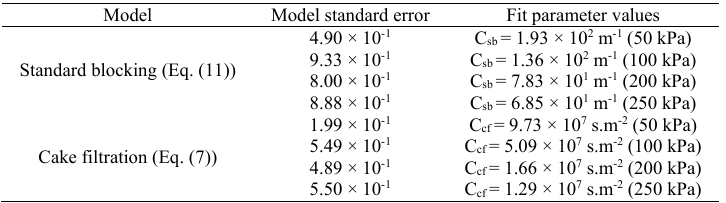
Table 3: Standard blocking and cake filtration model standard error values and fitted parameters of total resistance in skim milk Table 3 concentration using spiral wound ultrafiltration membrane module at different Model Model standard error